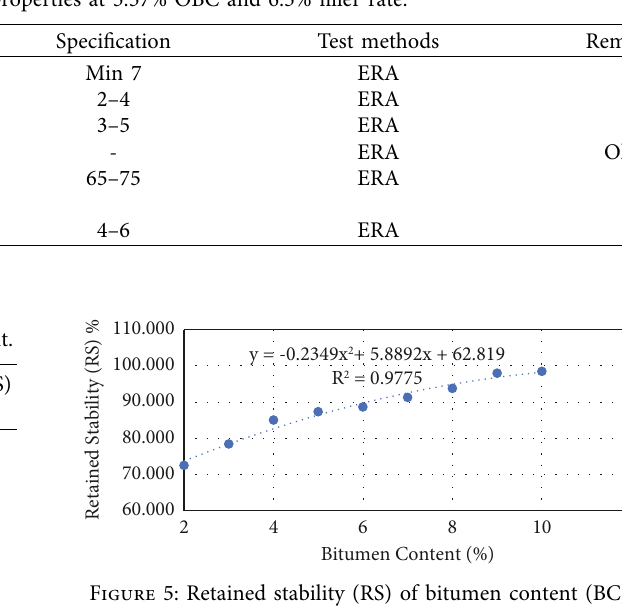
Table 14: Job mix formula (JMF) properties at 5.57% OBC and 6.5% filler rate.